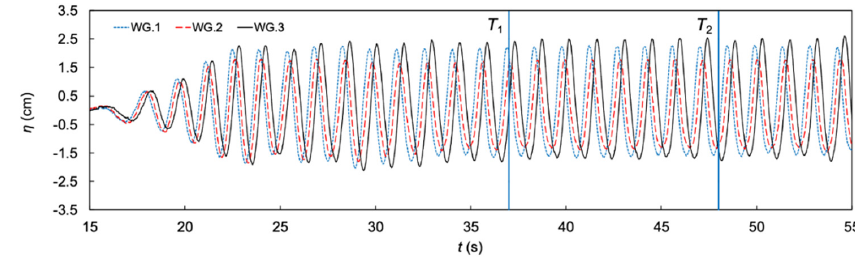
Figure 3. Time histories of free surface elevations η measured by WG.1 − 3.